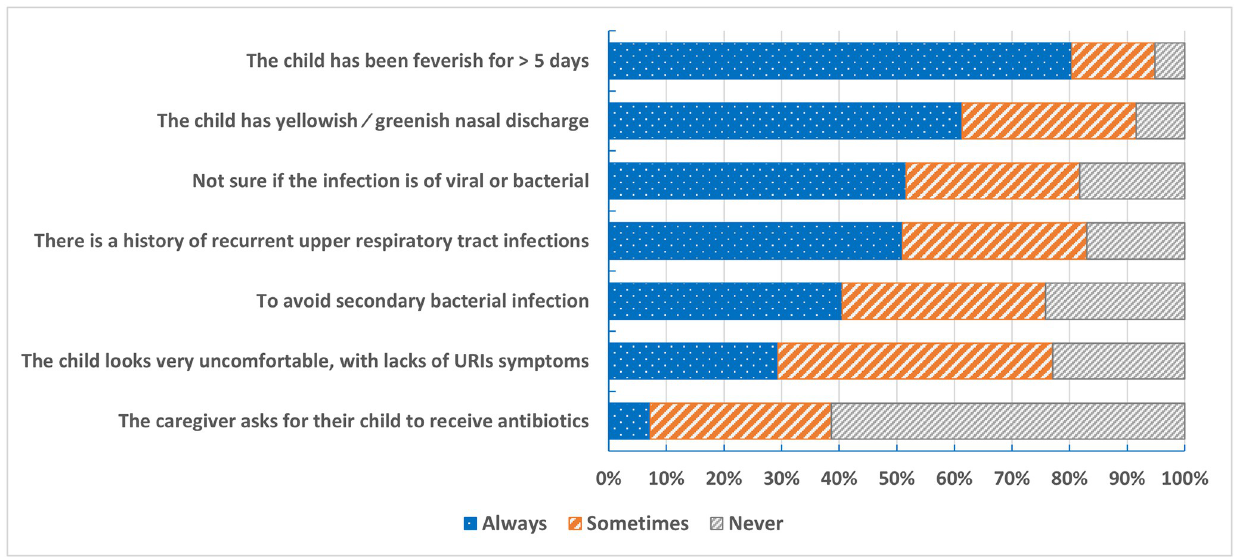
Fig 5. Prescribing practice in special conditions of URT